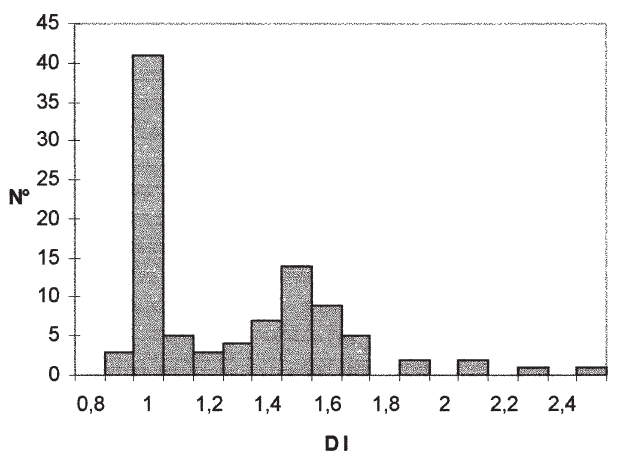
Fig. 6. Bar histogram showing DI distribution of the study population.